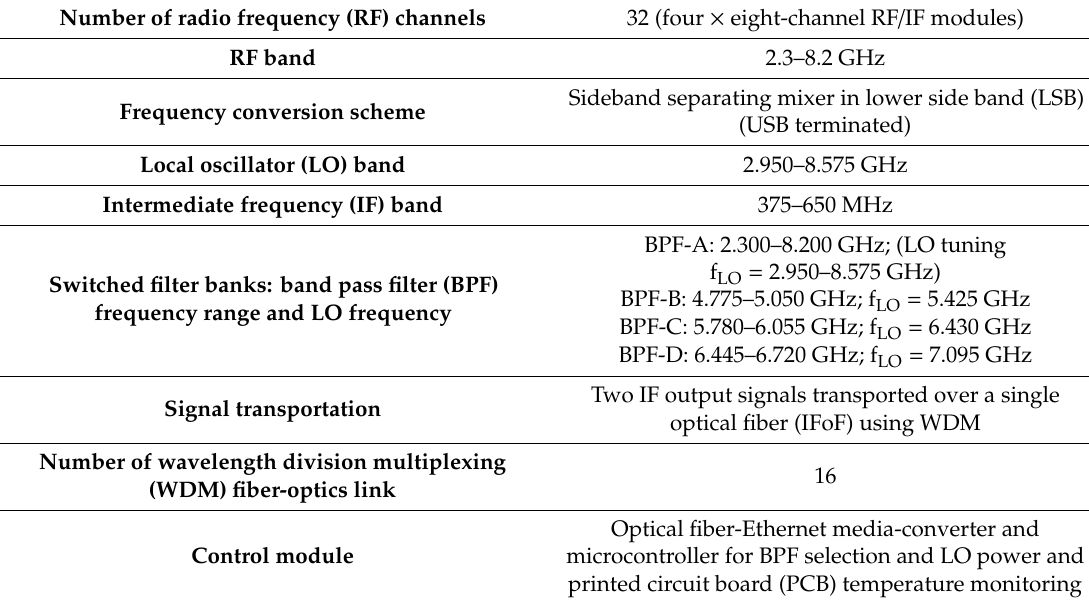
Table 1. Warm Section multi-channel